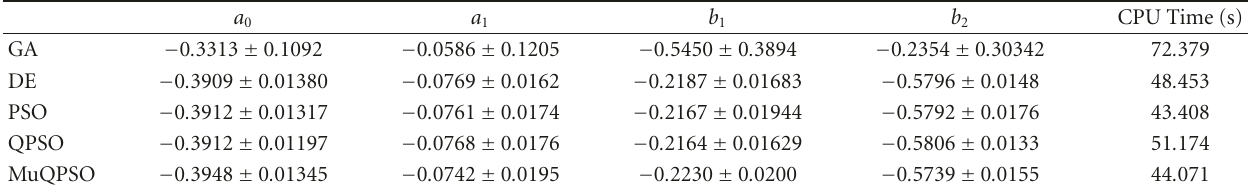
Table 5: Mean values and standard deviations of the filter coe ffi cients in Example 2 (mean of 100 random runs with randomly chosen initial positions).